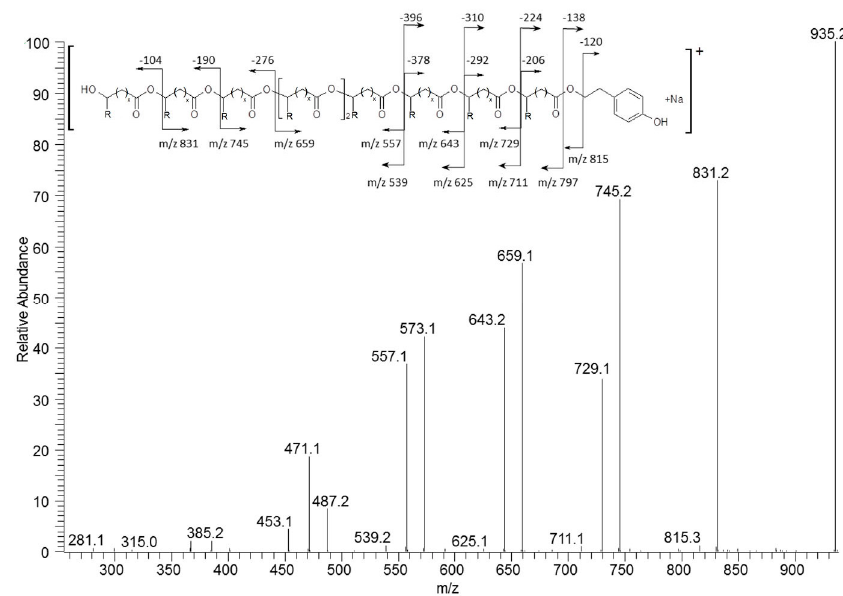
Figure 3. ESI-MS/MS product ion spectrum of the sodiated tyrosol-oligo(3HB- co -4HB) conjugate at m / z 935 and theoretical fragmentation pathway of this ion.